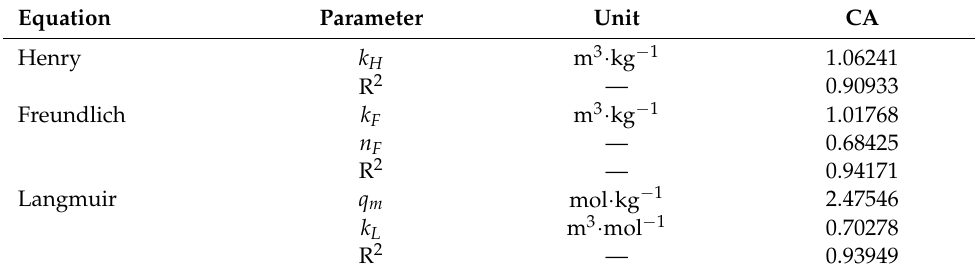
Table A22. Adsorption isotherm parameters for Ni(acac) 2 from scCO 2 solution on CA at 30 MPa and 333 K of different precursors